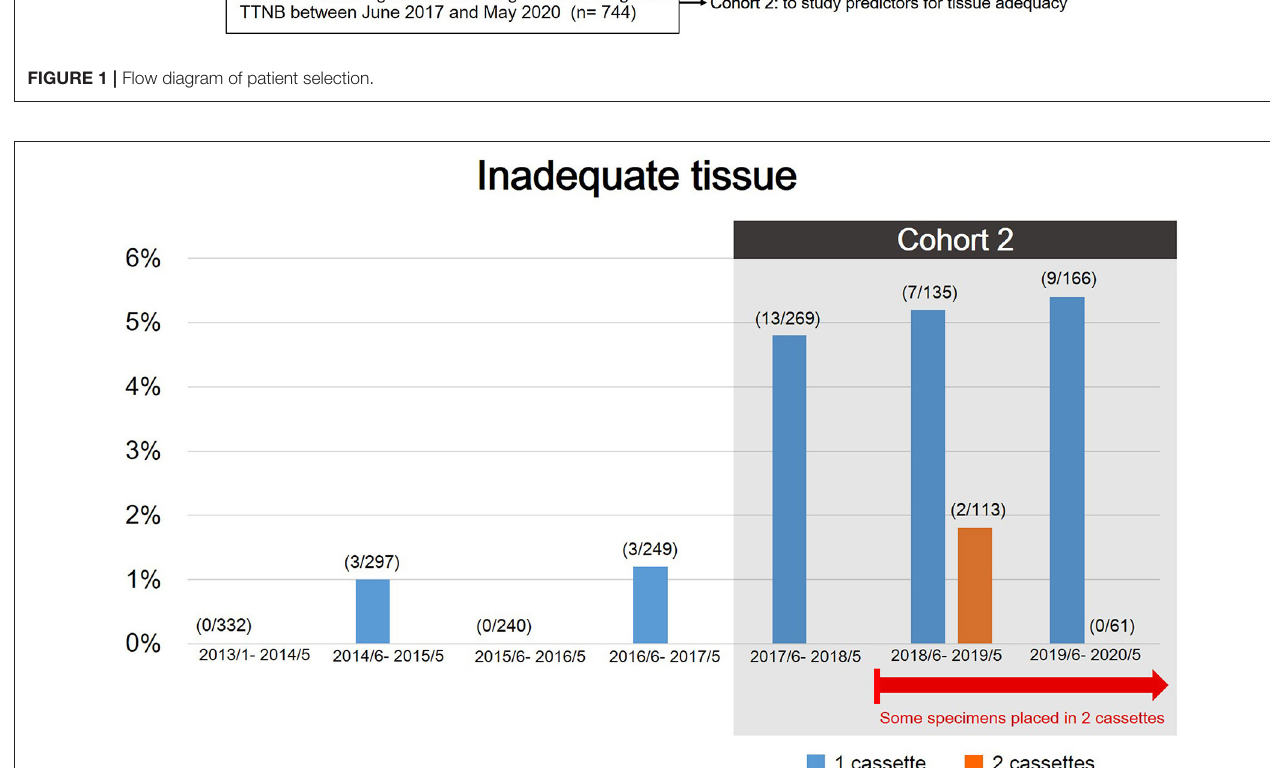
FIGURE 2 | The rate of inadequate tissue during the study period. There was an evident increasing rate of rebiopsy since June 2017 because of expanding molecular analyses and clinical trials. Patients diagnosed with malignancy via TTNB between June 2017 and May 2020 were defined as cohort 2 to further assess predictors for tissue